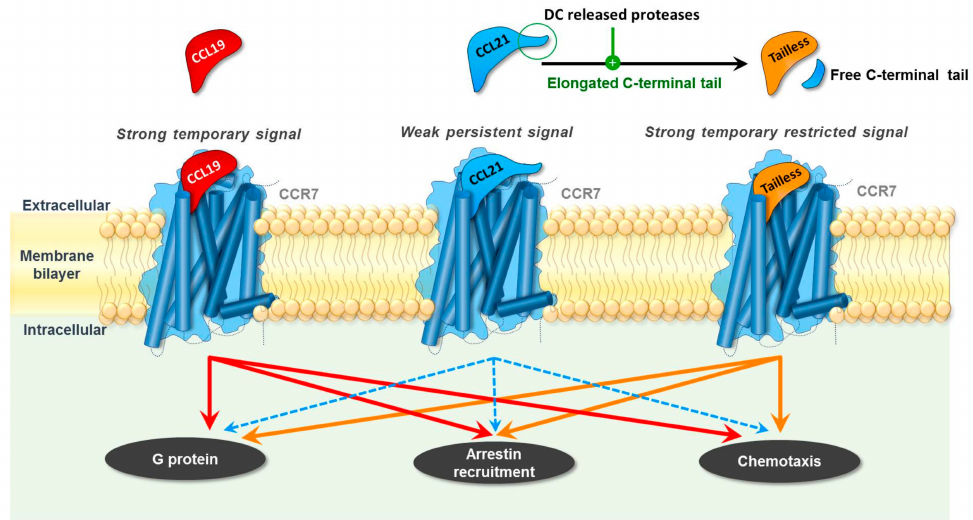
Figure 1. CCL19, CCL21, and Tailless-CCL21 (Tailless) induce differential signaling through their common receptor CCR7. Overall, CCL19 is a strong agonist of both G-protein signaling, β -arrestin recruitment, and chemotaxis, whereas CCL21 is a weak agonist. Upon cleavage by DC-released proteases, CCL21 is turned into Tailless-CCL21, which resembles CCL19 and, thus, is a strong agonist. Based on their differential expression pattern and activity in diverse signaling path- homeostasis and immunity, and that the in vivo cleavage of CCL21 by DC-released